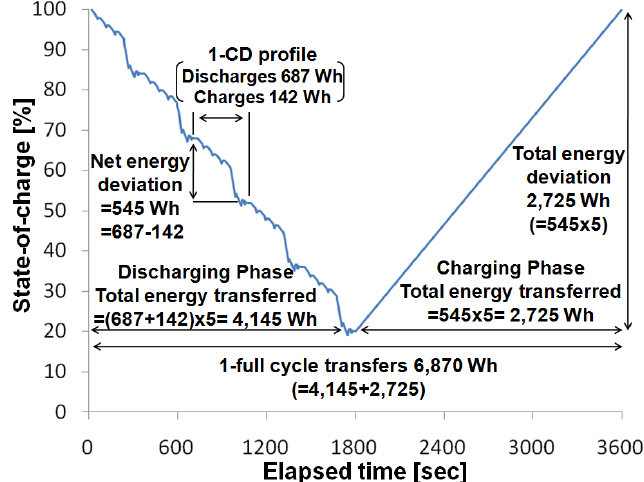
Figure 6. A single full cycle at 80% DOD with the CD profile for a minimum PHEV